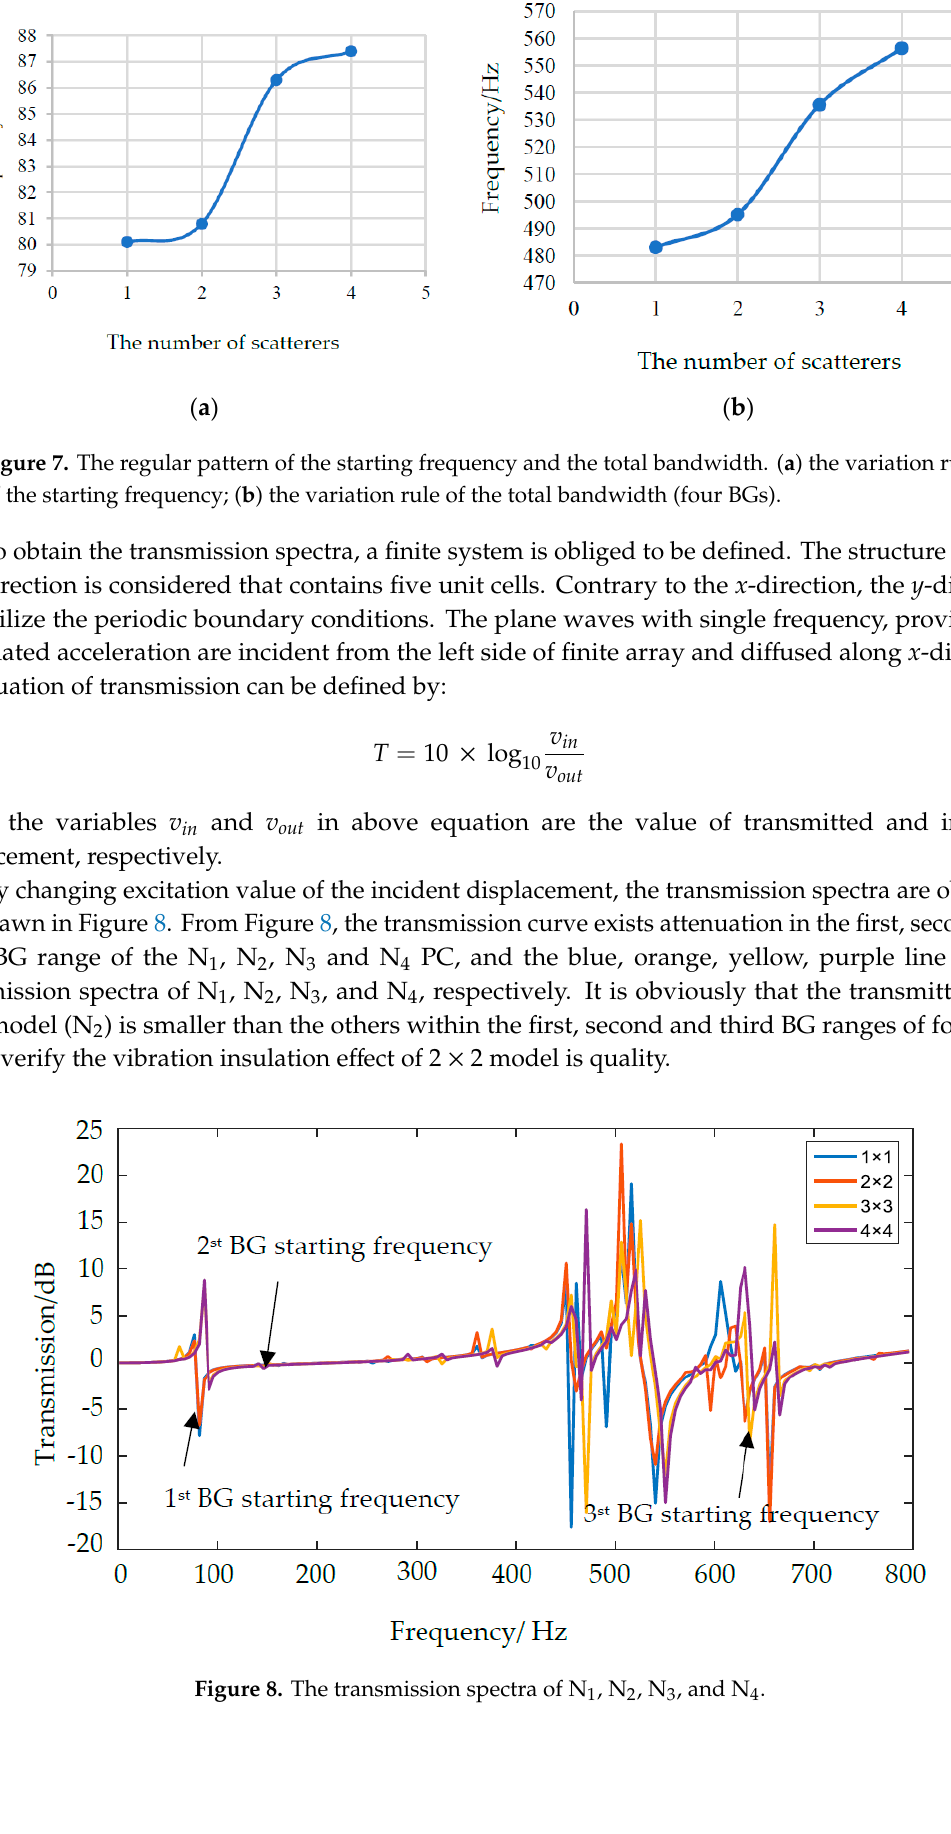
Figure 6. The vibration modes and displacement vector fields of the corresponding point in BGs of the PCs structure. ( a )( b )( c )( d )( e )( f )( g )( h )( i )